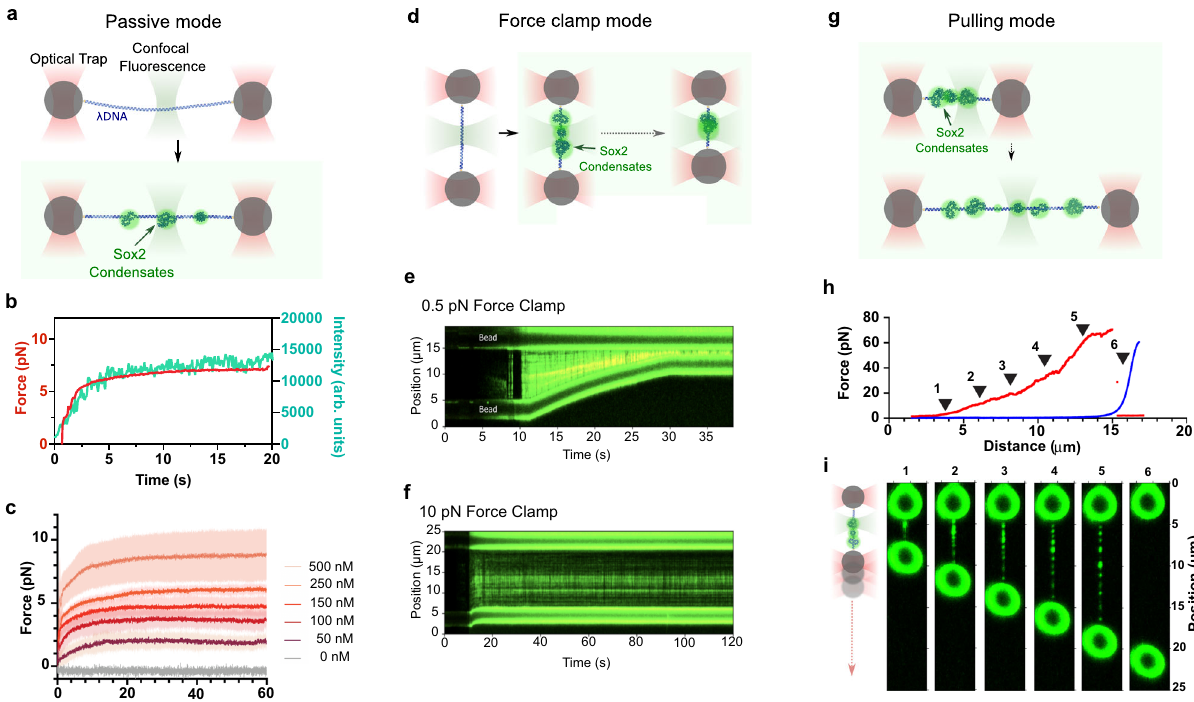
Fig. 3 Optical tweezers assays for quantitative measurements of the force generated by Sox2:DNA co-condensation. a Schematic of the optical tweezers assay that measures force generated by Sox2-mediated DNA condensation. The trap separation was fi xed in this experiment. b Force measurements (red) and the corresponding fl uorescence intensities (green) as a function of time for the assay depicted in a . Data are averaged from 4 representative tethers. c Force measurements made with different Sox2 concentrations. The colored lines correspond to the mean forces as a function of time averaged from multiple DNA tethers ( n = 4 or 5). The shades correspond to standard deviation. d Schematic of force-clamp experiments. The force applied to the tether was kept at a constant value via feedback such that DNA condensation would result in shortening of the tether. e A representative kymograph showing signi fi cant tether contraction and Sox2 condensate formation under a 0.5-pN force clamp. f A representative kymograph showing suppressed tether contraction under a 10-pN force clamp. g Schematic of pulling experiments. Sox2 condensates fi rst formed on tethered λ DNA under a low force (~0.5pN). The tether was then subjected to mechanical pulling by gradually separating the two traps apart. h A representative force-distance curve from pulling a λ DNA tether harboring Sox2 condensates (red line) in comparison to a representative curve from pulling a bare λ DNA (blue line). The black arrowheads denote selected time points imaged in i . i Two-dimensional fl uorescence scan of the same tether as in h (red line) at selected time points during pulling showing that Sox2 condensates persisted under forces up to 60pN (time points #1 – 5) until tether rupture (time point #6). Source data are provided as Source Data Fig.